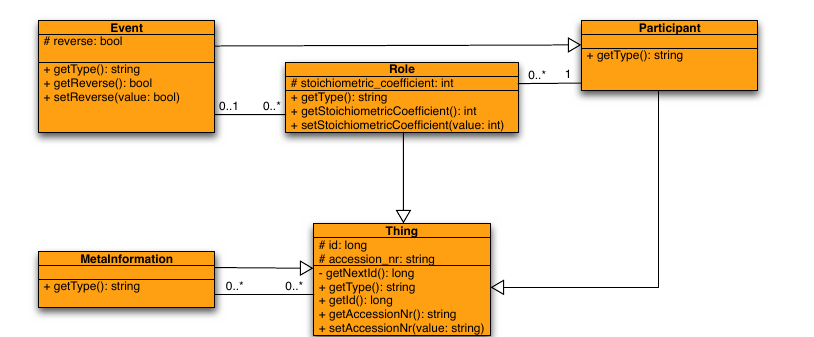
Figure 2: UML diagram of the central kernel classes in the biochemical network library (simpli- fi